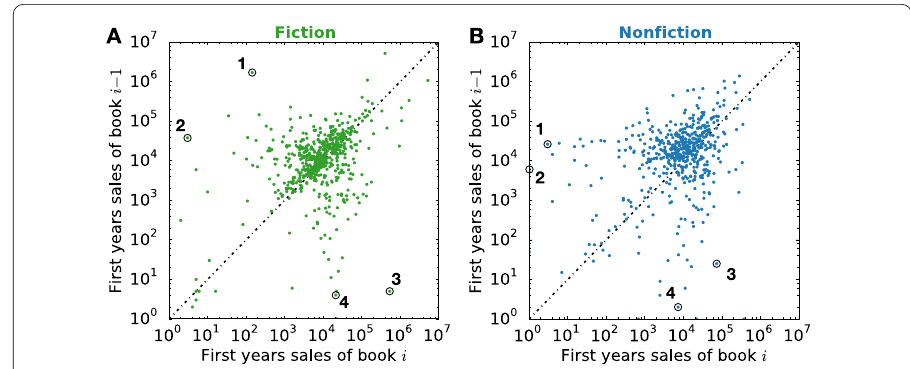
Figure 7 Previoussalesmatter . The relation between the sales of the previous hardcover i – 1 and the sales of the next one, i , by the same author, for ( A ) fiction and ( B ) nonfiction. Best selling authors tend to sustain their success with new books, as most dots lie close to the 45 degree line. The outlier books, discussed in the main text, are written by (1) Stieg Larsson, (2) Annie Barrows, (3) Melissa de la Cruz and (4) John Jackson Miller for ( A ) and (1) Kristin Chenoweth, (2) Kay Robertson, (3) Eric Blehm and (4) Lady Colin Campbell for ( B ). They are either books written in a different genre from the previous bestselling books of the author, or reissues of old books with a different